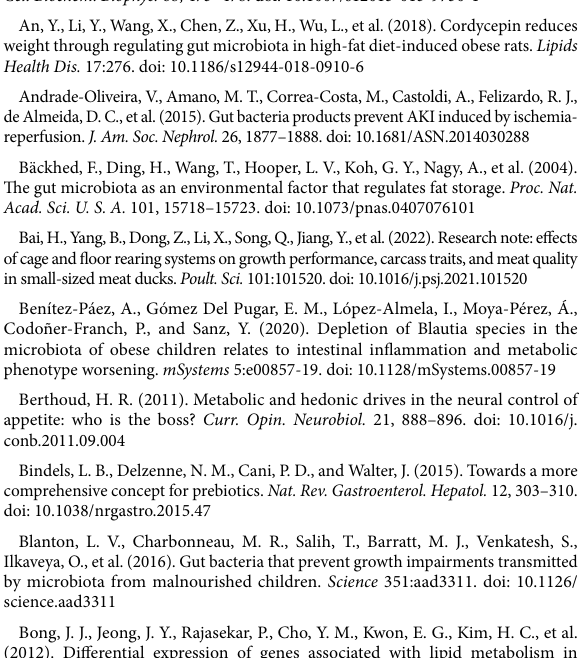
SUPPLEMENTARY FIGURE S1 KEGG pathways enriched in Xinjiang Brown and Angus cattle microbiomes. SUPPLEMENTARY FIGURE S2 Classification of differential metabolites. SUPPLEMENTARY FIGURE S3 Metabolic pathway impact analysis. Alanine, aspartate and glutamate metabolism (-log(p) 4.52; Impact 0.63) (A); D-Glutamine and D-glutamate metabolism (-log(p) 1.89; Impact 1.00). SUPPLEMENTARY FIGURE S4 Correlations of the species (RA abv 0.1%) - MQT-LMs -